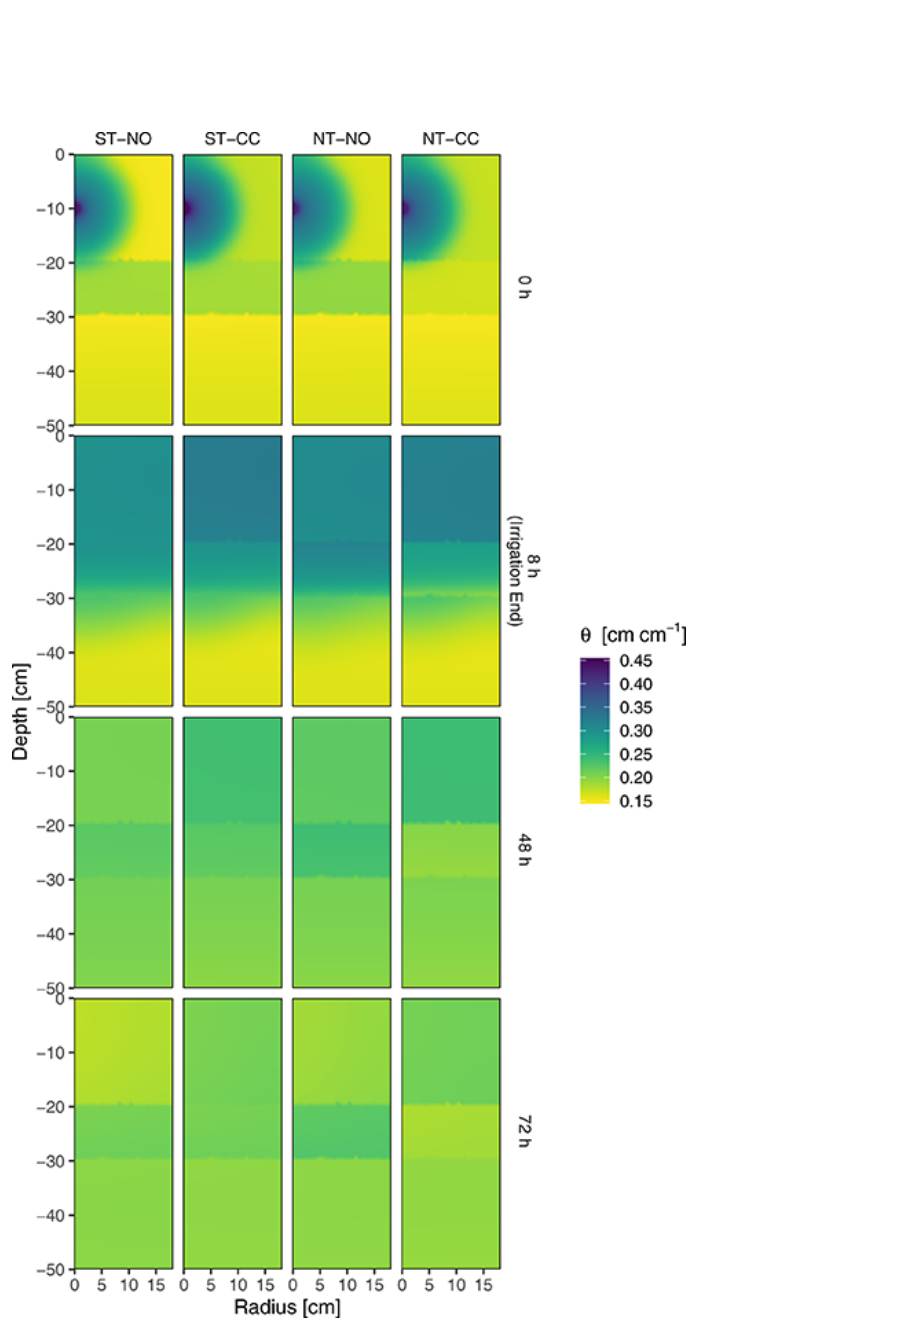
https://doi.org/10.5194/soil-8-177-2022 SOIL, 8, 177–198,